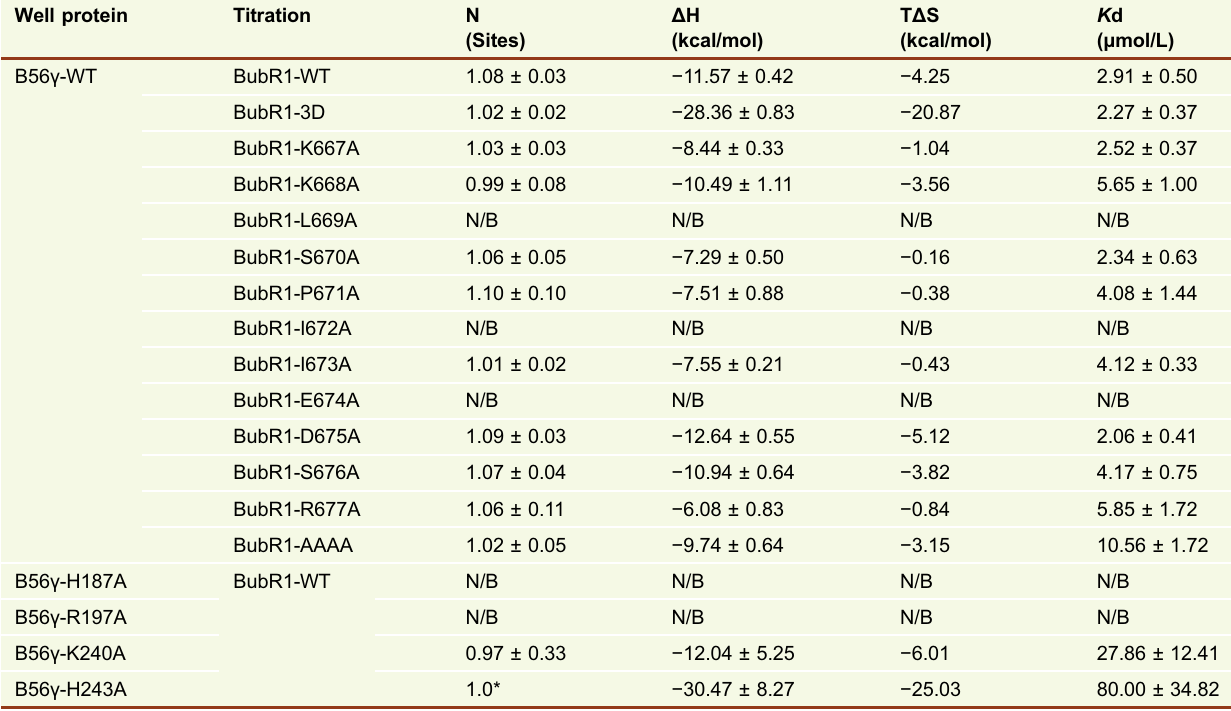
Table 1. Summary of ITC analysis of the PP2A B56-BubR1 interaction Well